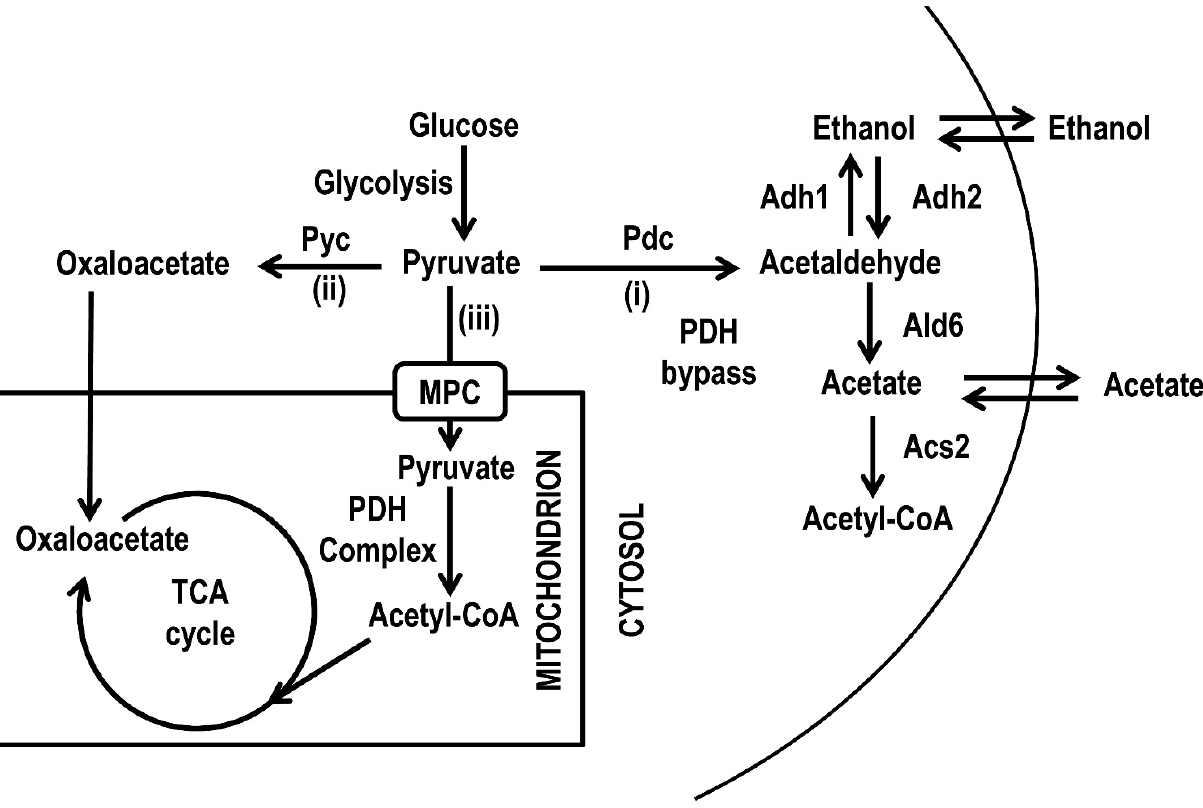
FIGURE 1: Scheme of metabolic pathways allowing pyruvate utilization. The three pathways which originate from pyruvate after (i) decarboxylation to acetaldehyde, (ii) carboxylation to oxaloacetate and (iii) oxidative decarboxylation to acetyl-CoA are schematically shown. Acs, acetyl-CoA synthase; Adh, alcohol dehydrogenase; Ald, aldehyde dehydrogenase; MPC, mitochondrial pyruvate carrier; Pdc, pyruvate decarboxylase; PDH, pyruvate dehydrogenase; Pyc, pyruvate